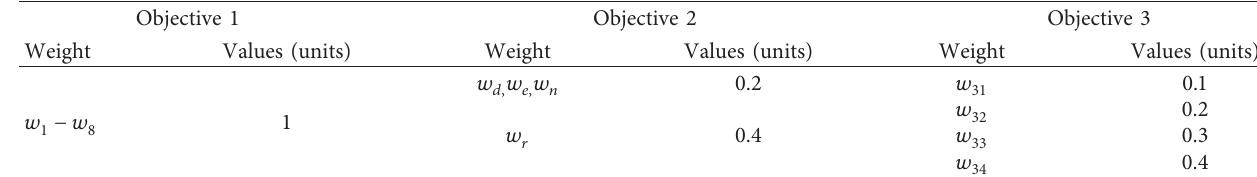
Table 6: Weight values in MLNRP.